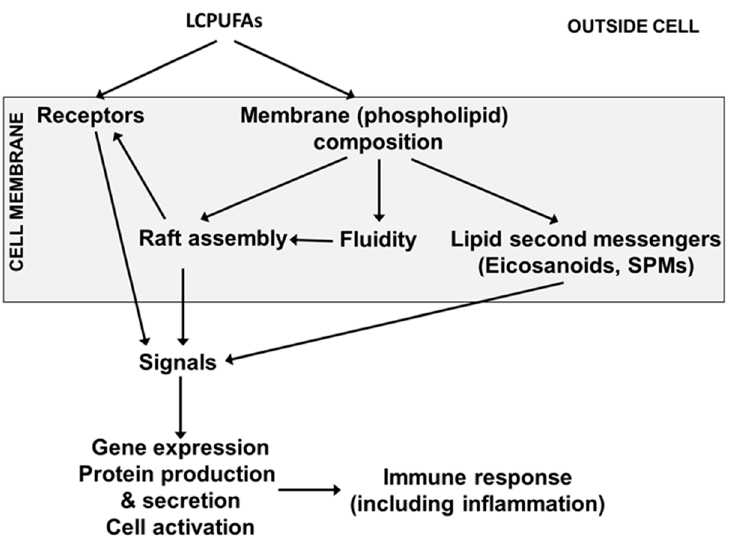
Figure 4. Mechanisms by which LCPUFAs can affect immune cell function SPM, specialised pro- resolving mediator.